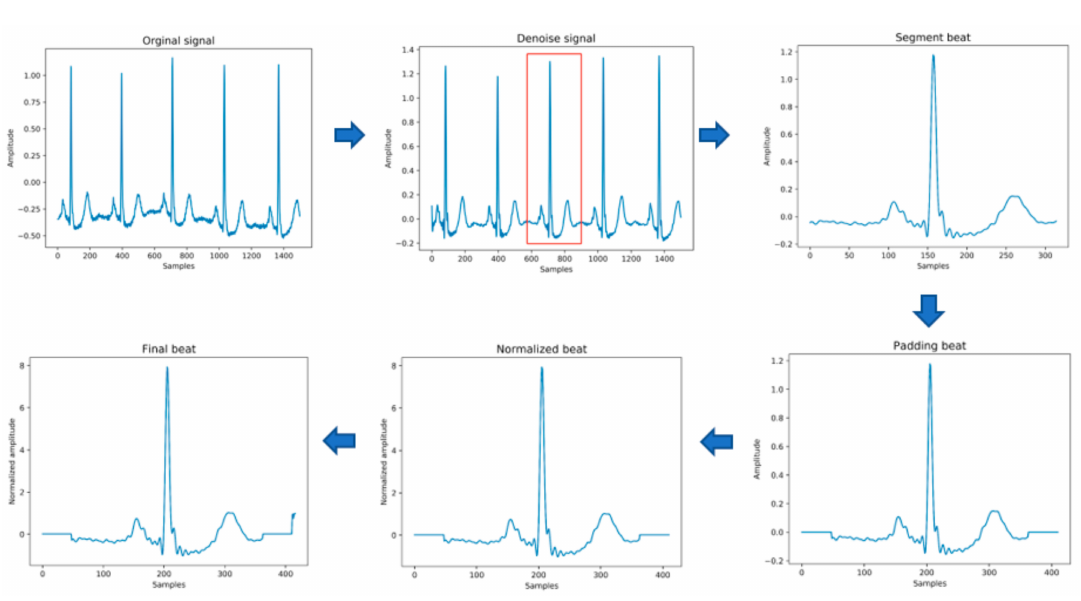
Figure 3. The process of input data